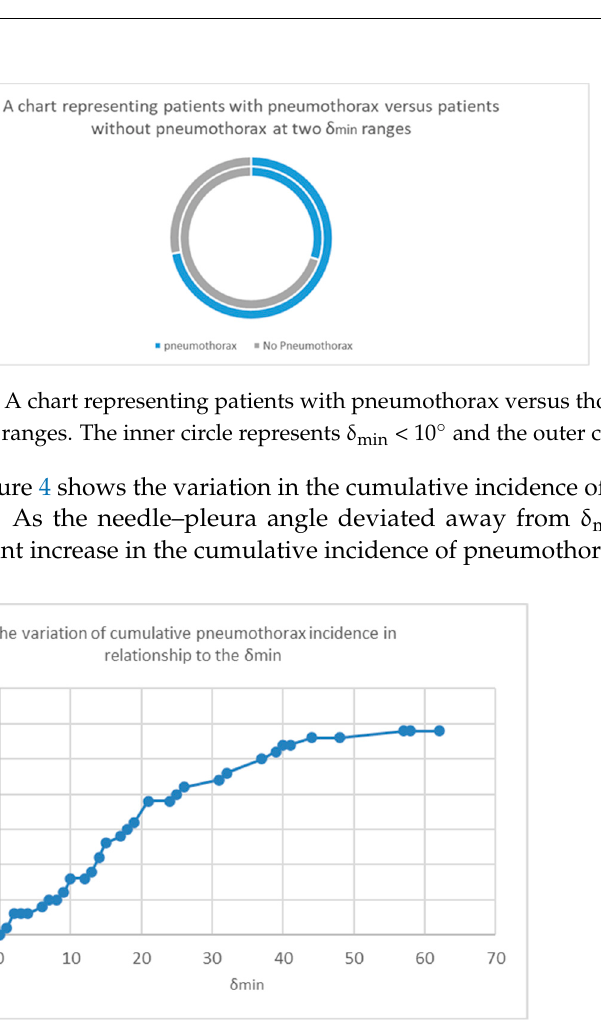
Figure 4. The variation in cumulative pneumothorax incidence in relation to the δ min . Of the patients who had a δ min < 10°, 30% experienced pneumothorax compared to 71.8% of the patients who had a δ min ≥ 10° ( p = 0.0023), as presented in Figure 5. Only 1 of 20 patients (5%) who had a δ min < 10° needed a chest tube, compared to 8 of 32 patients (25%) who had a δ min ≥ 10° ( p = 0.0017).